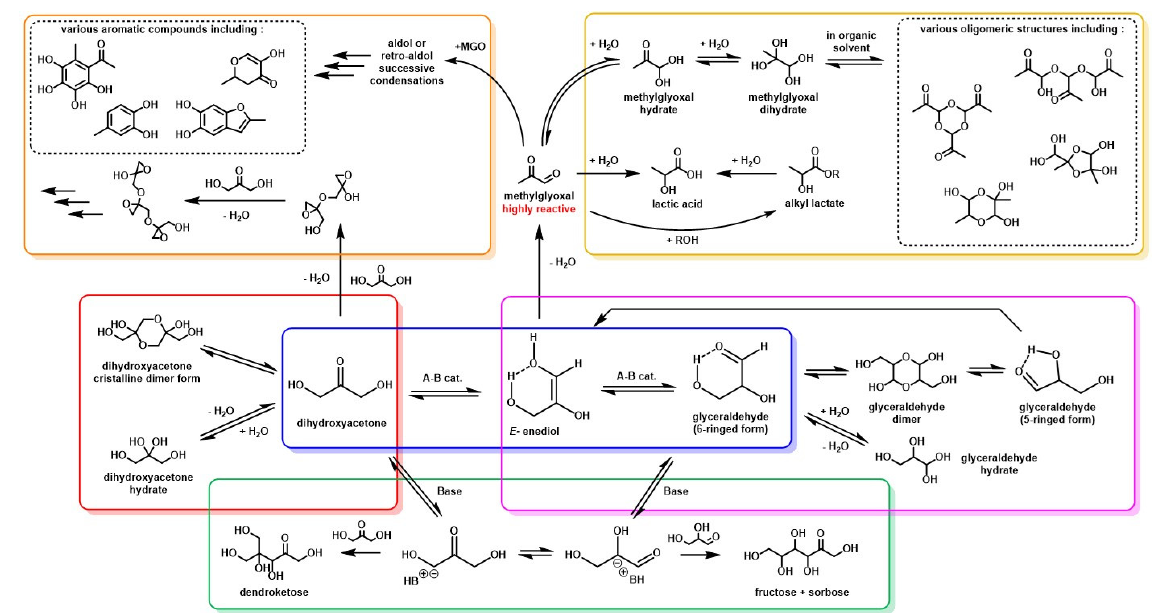
Figure 7. General reaction scheme of the various compounds derivable from DHA in common solutions.